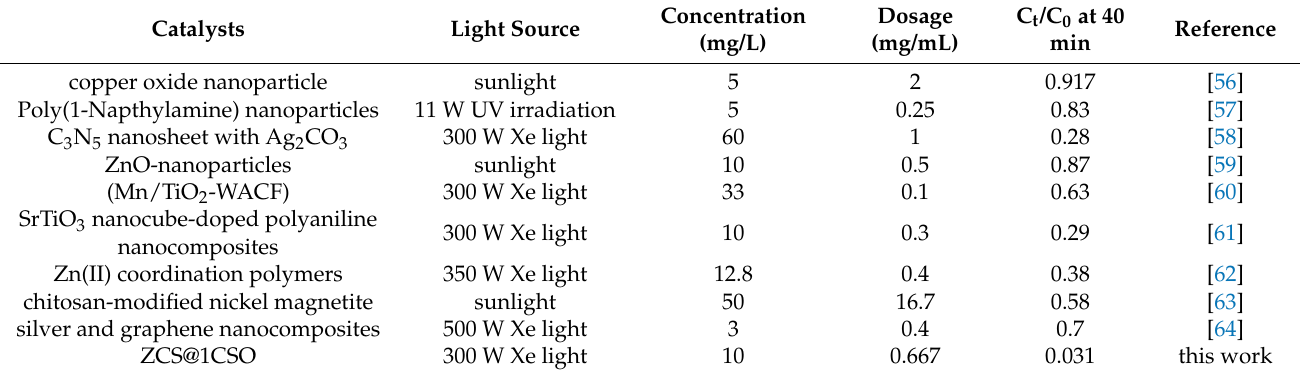
Table 2. The photocatalytic degradation performance of MB for recent catalysts.